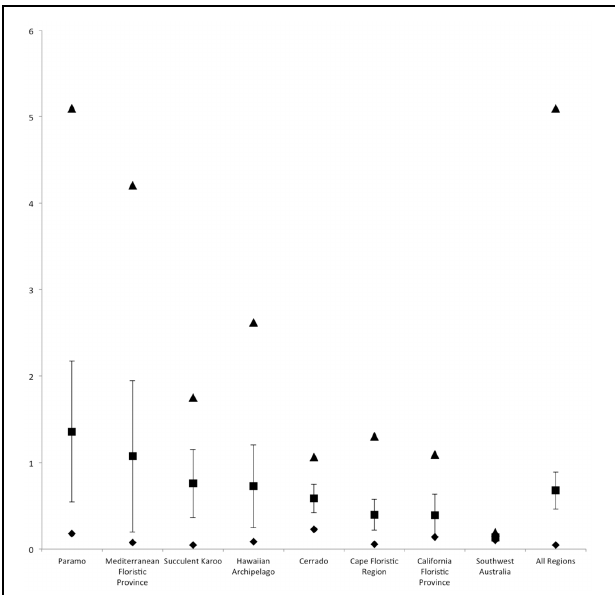
FIGURE 3 | Comparison of net diversification rates ( r ) in fast evolving biodiversity hotspots. Upper (triangle), lower (diamond), mean (square) and Standard Deviation around the mean net diversification rates (Y axis) for each hotspot. Sample sizes: Páramos n = 13; Mediterranean Floristic Province n = 8; Succulent Karoo n = 9; Hawaiian Archipelago n = 9; Cerrado n = 10; Cape Floristic Region n = 13; California Floristic Province n = 6; Southwest Australia n = 5; All Regions n =